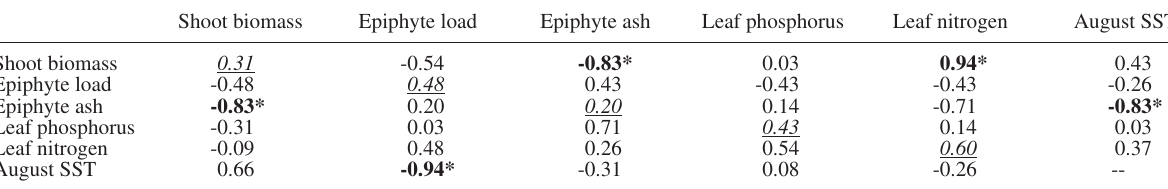
Table 2. – Results of Spearman rank correlation analysis evaluating the association between shoot biomass, epiphyte load, ash content of the epiphytes, and nitrogen and phosphorus content of the leaves of Posidonia oceanica and August SST at Magaluf (above main diagonal) and Ses Salines (below main diagonal) during the 2003-2008 period. Correlations of P. oceanica descriptors between Magaluf and Ses Salines are presented in main diagonal. *, P <0.05.